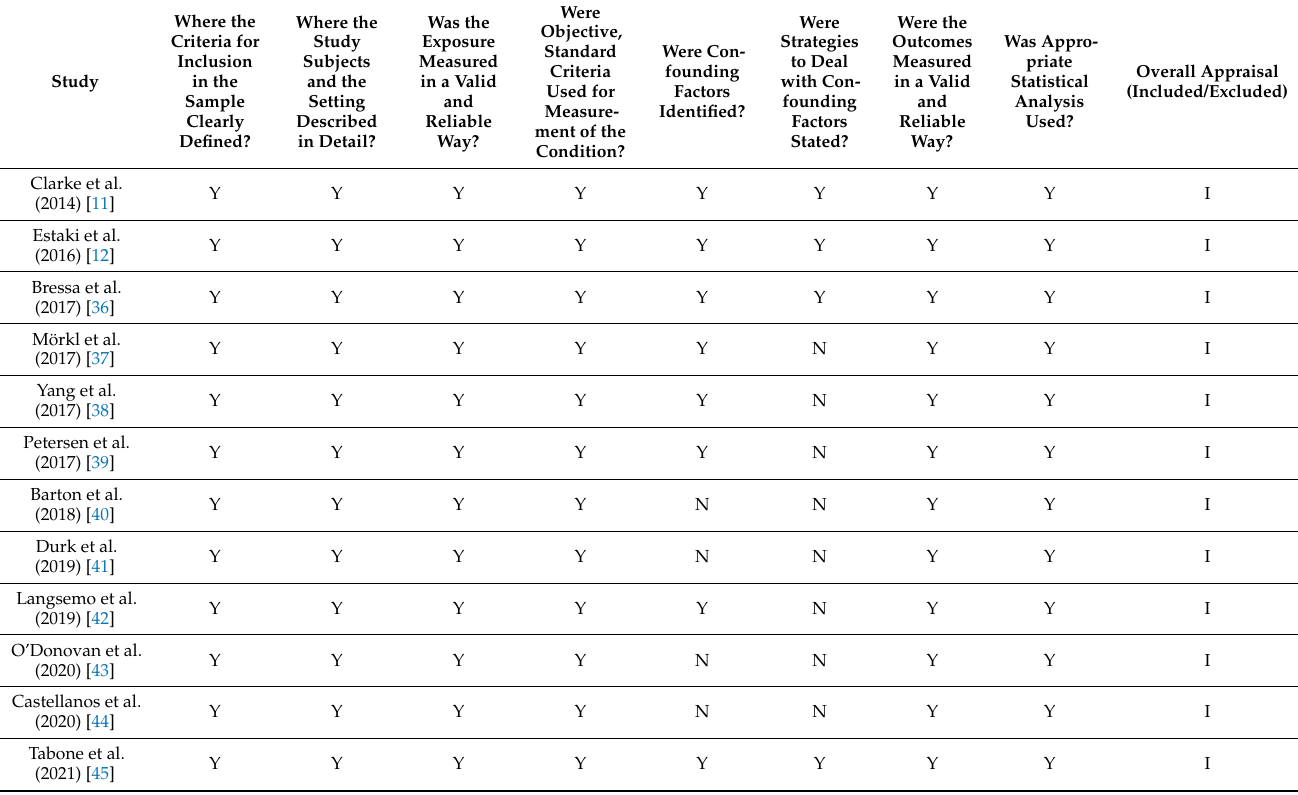
Table 4. JBI Critical Appraisal Checklist for Analytical Cross-Sectional